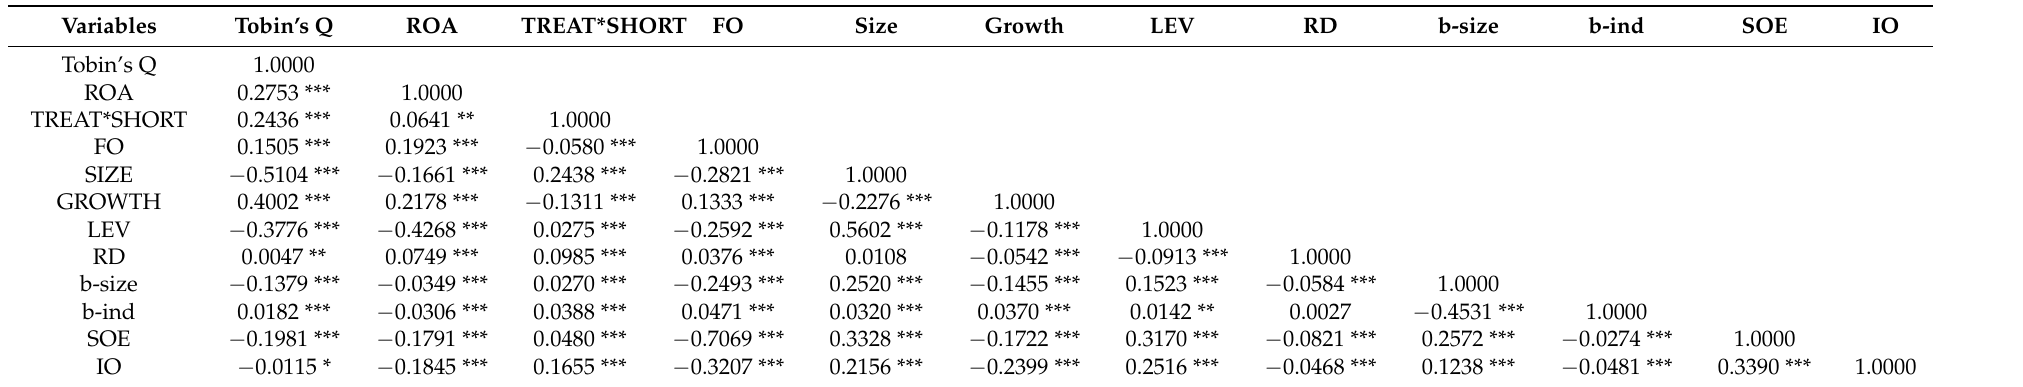
Table 4. Pearson correlation